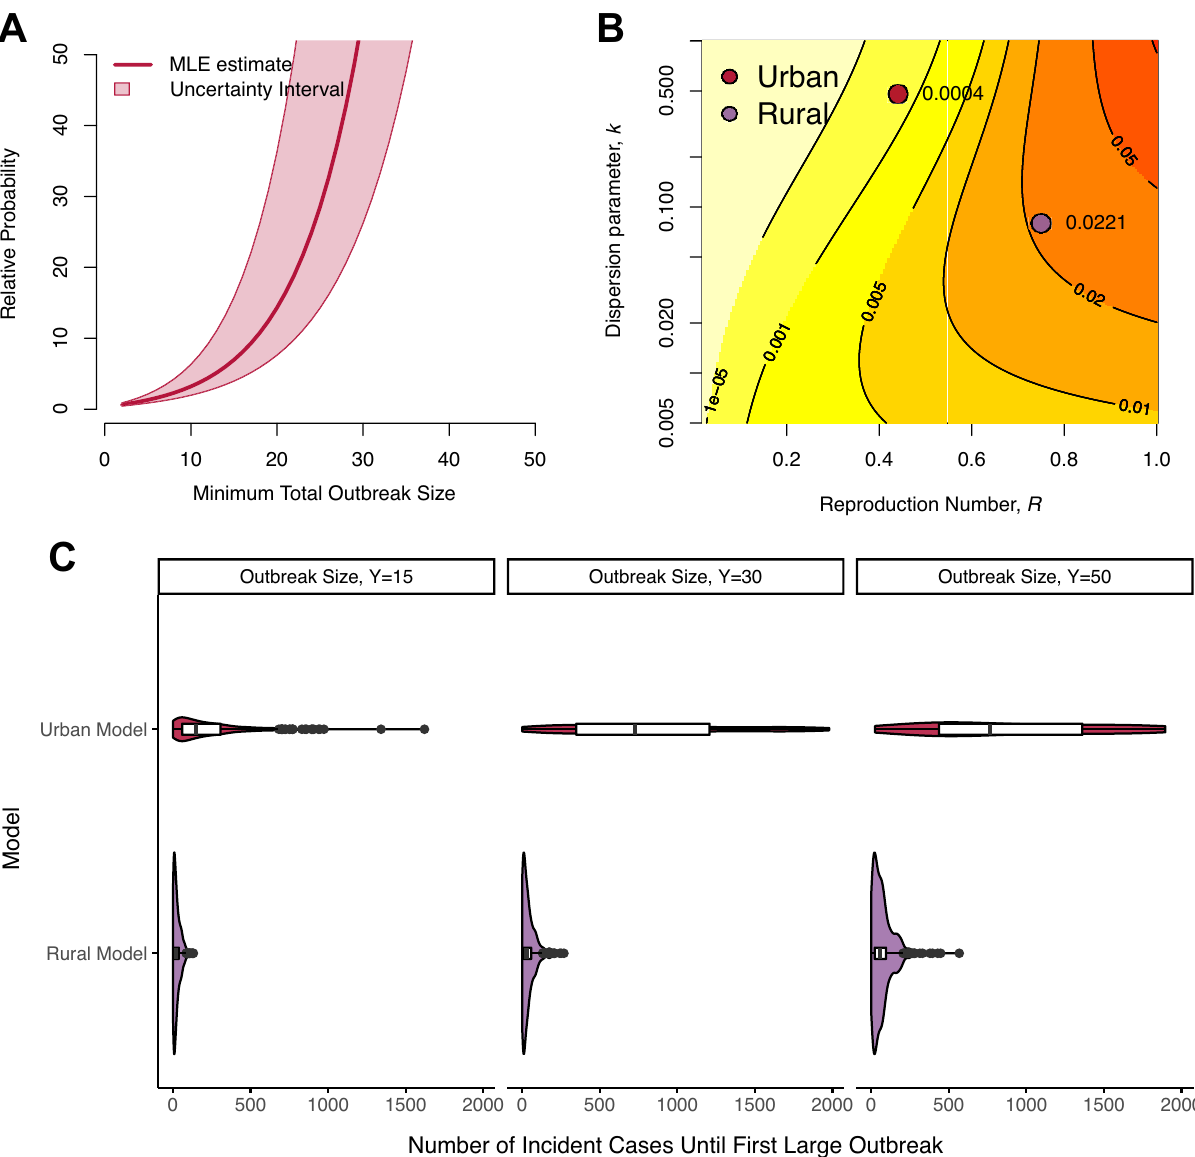
Figure 4. Comparison of large TB outbreaks in high-burden urban and rural settings. ( A ) Relative probability of observing a large outbreak of at least size Y generating from a single case in a rural population compared to an urban population; ( B ) Absolute probability that a single case results in an outbreak of size of 30 or greater. Colored contours indicate probability bands, with associated probabilities indicated on each band. Setting-specific estimates are provided for clarity. ( C ) Density curves for the number of incident cases until first observed outbreak of size Y = 15 , Y = 30 , and Y = 50 resulting from a single index case. Nested boxplots represent the median and interquartile range of 500 simulated surveillance systems, each with 2000 transmission chains (supplemental materials Sect. 1.8). All Y values were arbitrarily chosen to represent sufficiently large